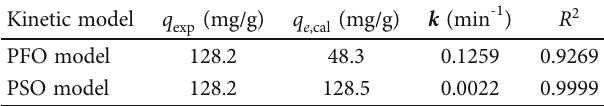
Table 2: Parameters of the PFO and PSO kinetic models for the adsorption of MB on δ -MnO 2